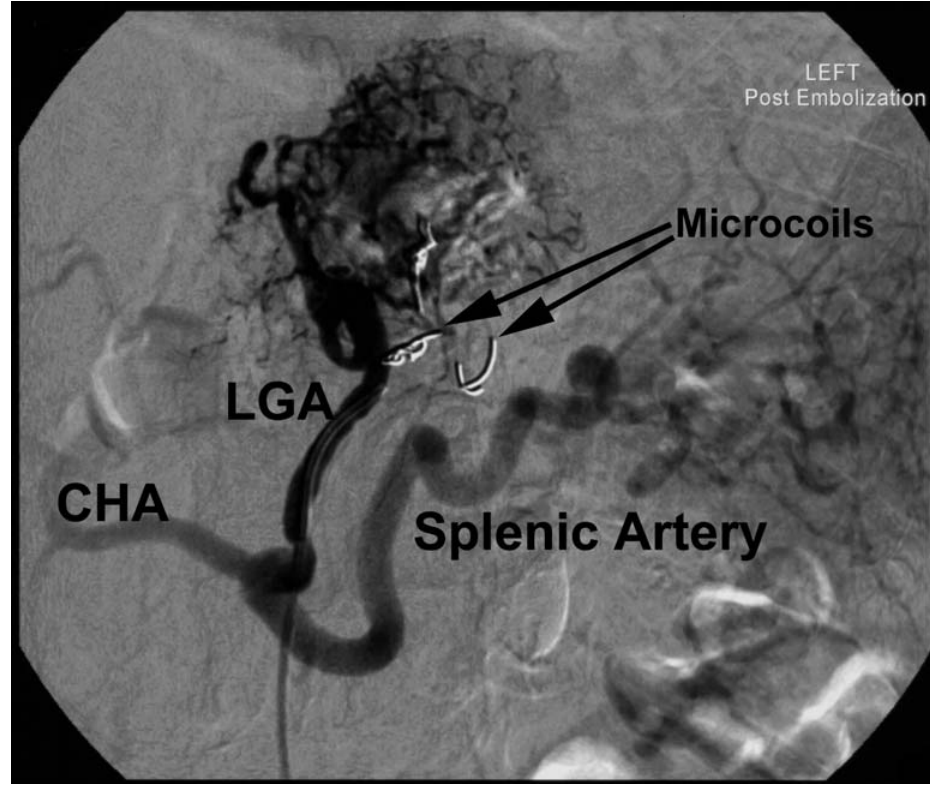
FIGURE 3 . The left gastric artery has been selectively catheterised with a Tempo 4 C2 catheter and a coaxial microcatheter used to assess the feeding artery of the